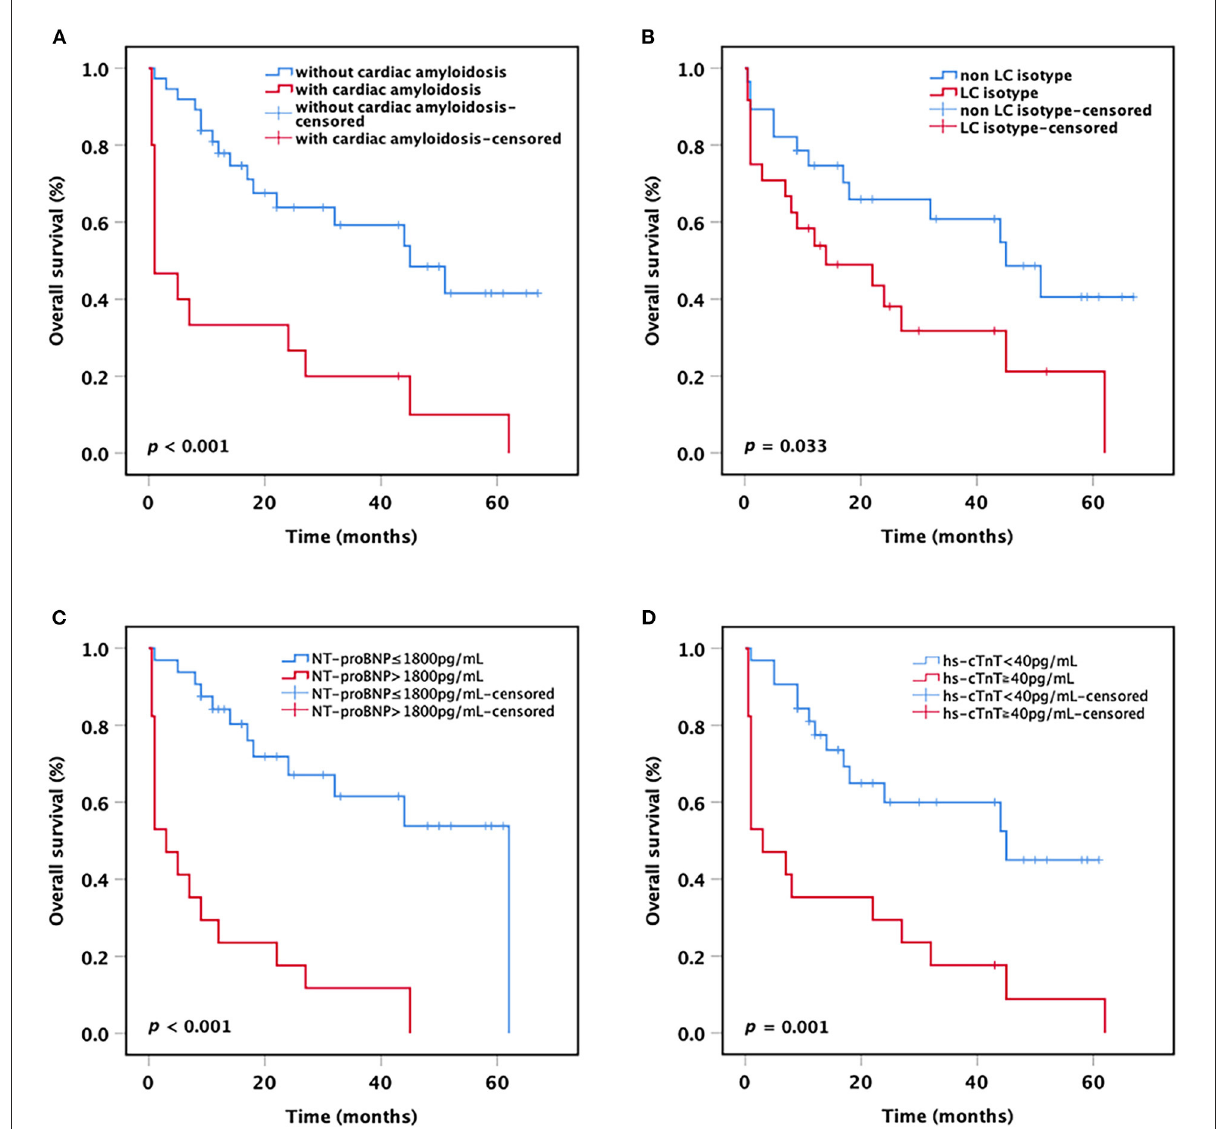
FIGURE1 Kaplan-Meier curves. OS of t(11;14) MM patients (A) with or without cardiac amyloidosis, (B) with or without LC only, (C) with or without NT-proBNP > 1,800 pg/ml, and (D) with or without hs-cTnT ≧ 40 pg/ml. OS, overall survival; LC, light chain; NT-proBNP, N-terminal pro-B-type natriuretic peptide; hs-cTnT, high-sensitivity cardiac Troponin T.